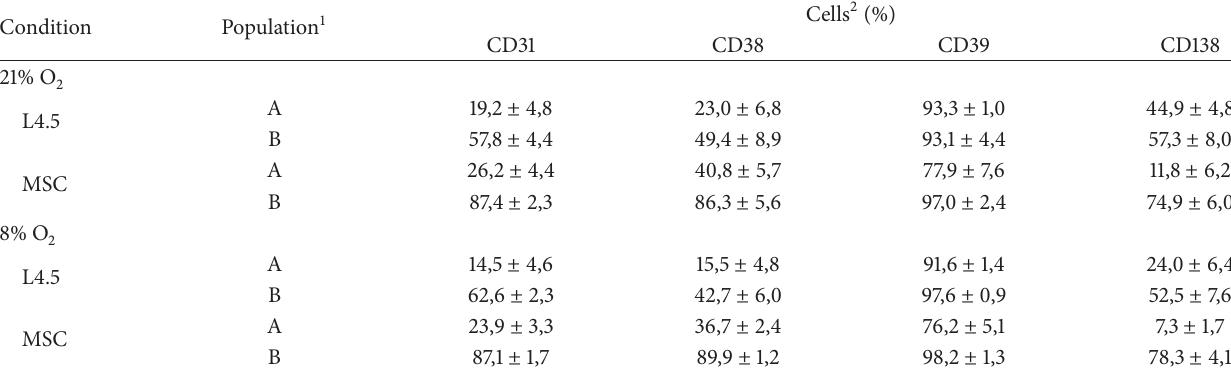
Table 1: Expression of CD31, CD38, CD39 and CD138 among plasma cells population on day